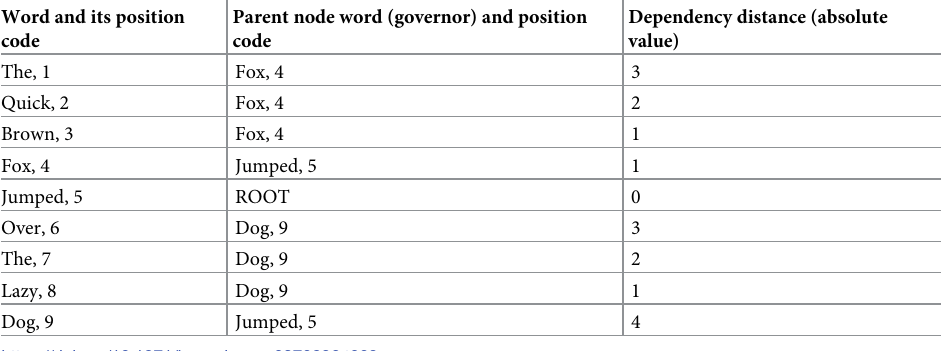
Table 3. Dependency distance per word